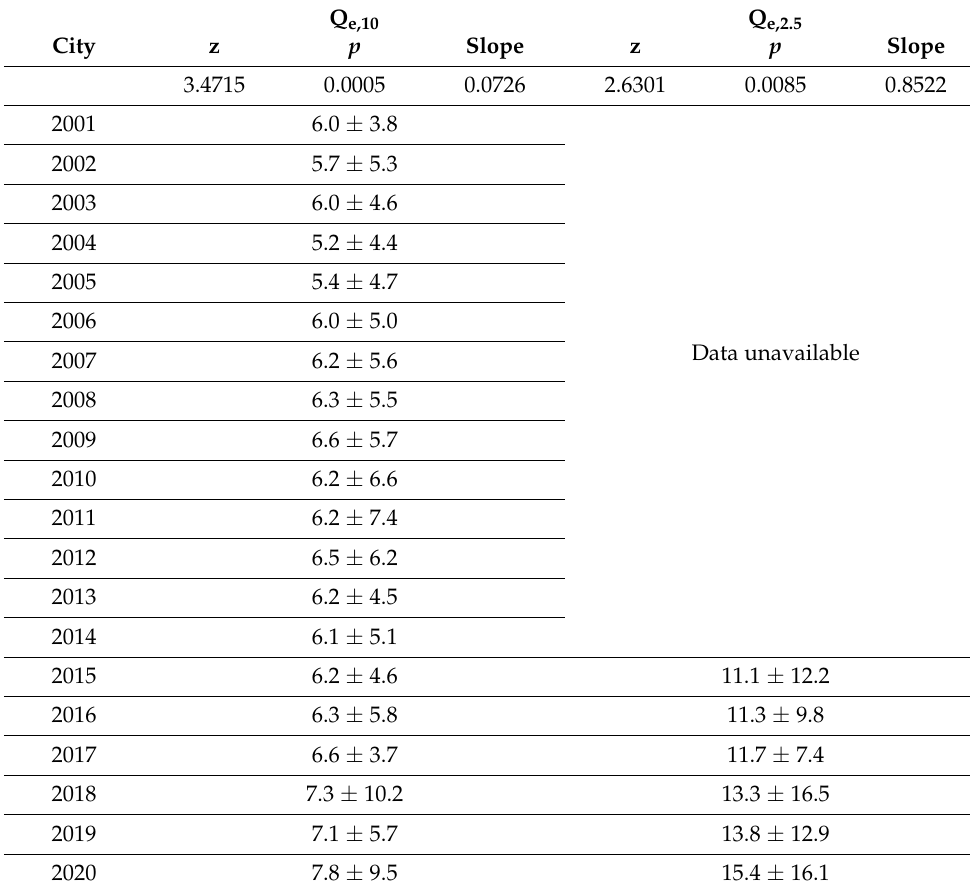
Table 4. Total Q e,10 (2001–2020), Q e,2.5 (2015–2020) with MK test and Sen’s slope. Q e,10 Q e,2.5 City z